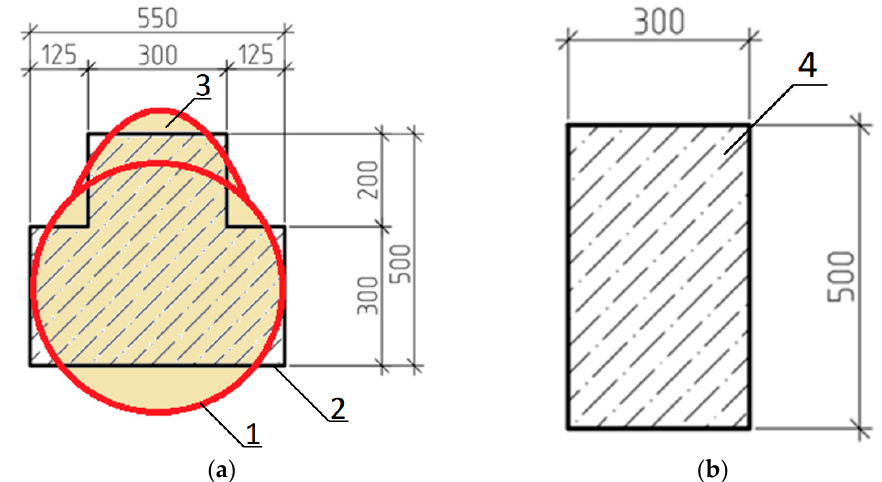
Figure 2. Studied sections of rod elements: ( a )—approximation of the section of a screw pile by replacing curvilinear sections with an equivalent composite tee, ( b )—section that perceives shear according to Russian standards, where: 1—pile shaft; 2—equivalent tee section; 3—thread trace in the section plane; 4—rectangular section, equivalent to a tee. Dimensions are in mm.